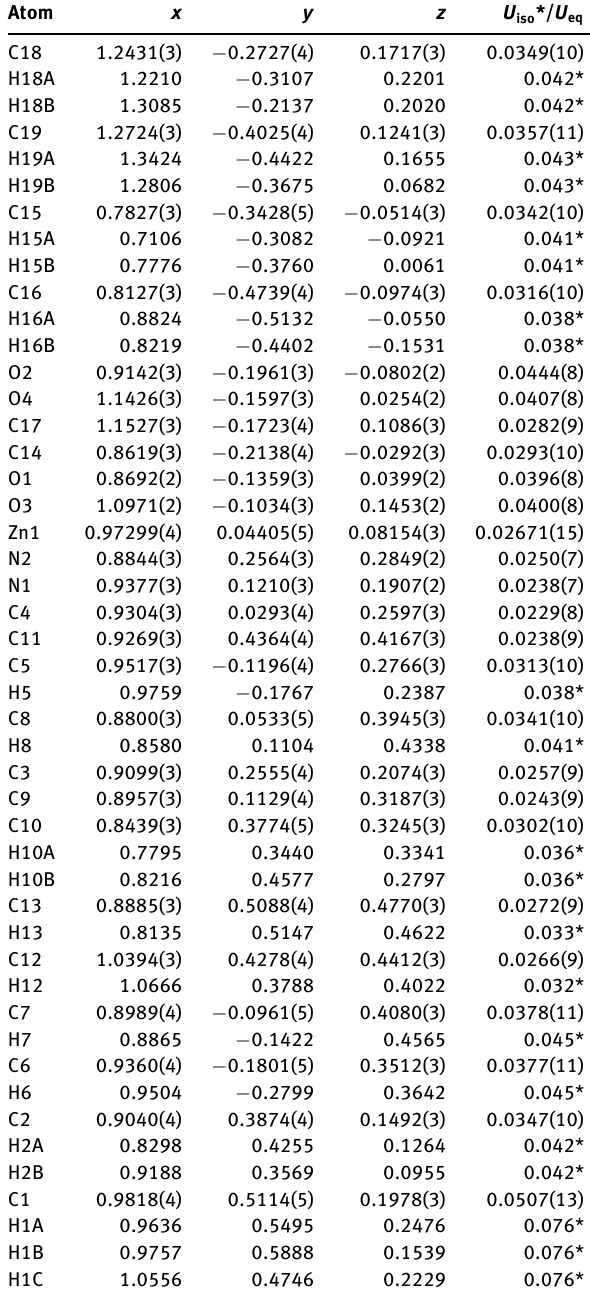
Table 2: Fractional atomic coordinates and isotropic or equivalent isotropic displacement parameters (Å 2